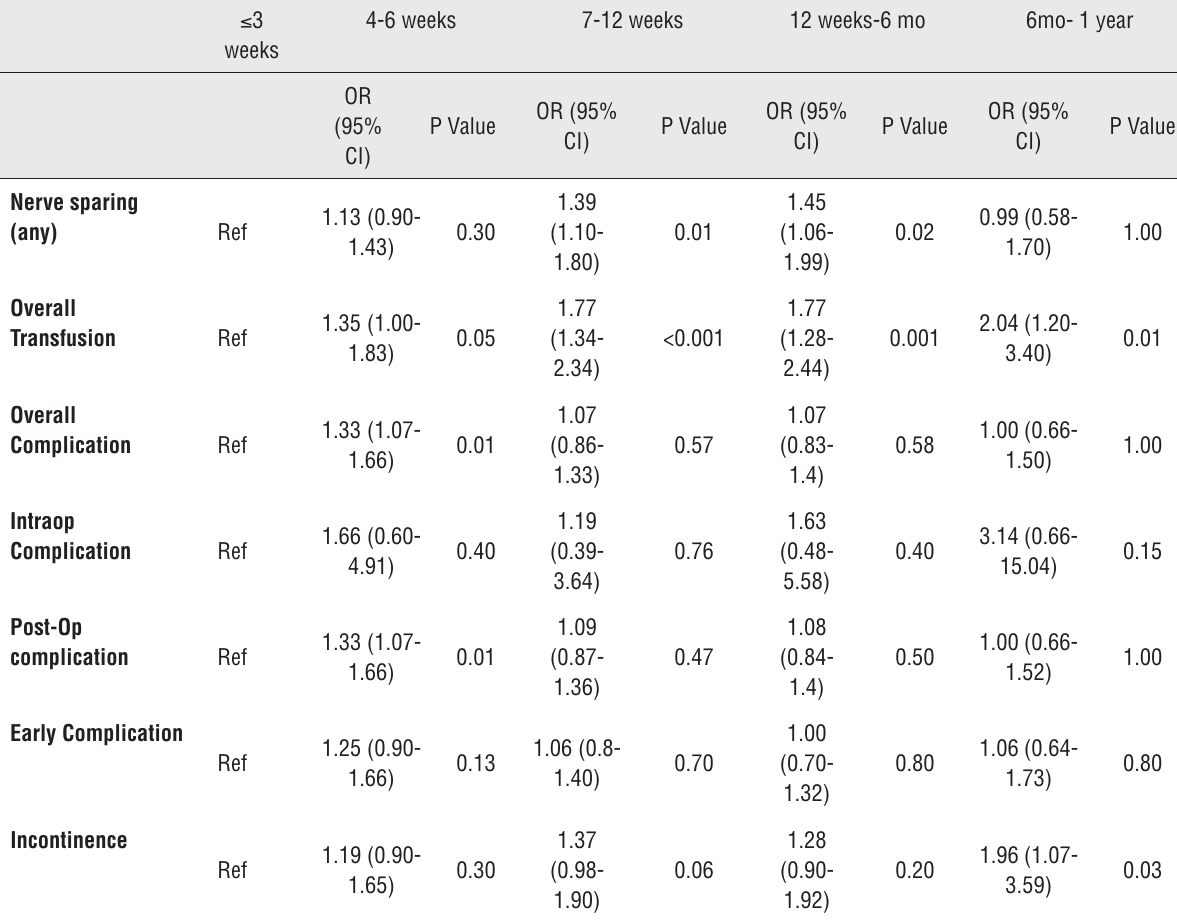
Table 2 - Logistic Regression analysis assessing impact of time from biopsy on peri-operative complications. * ≤